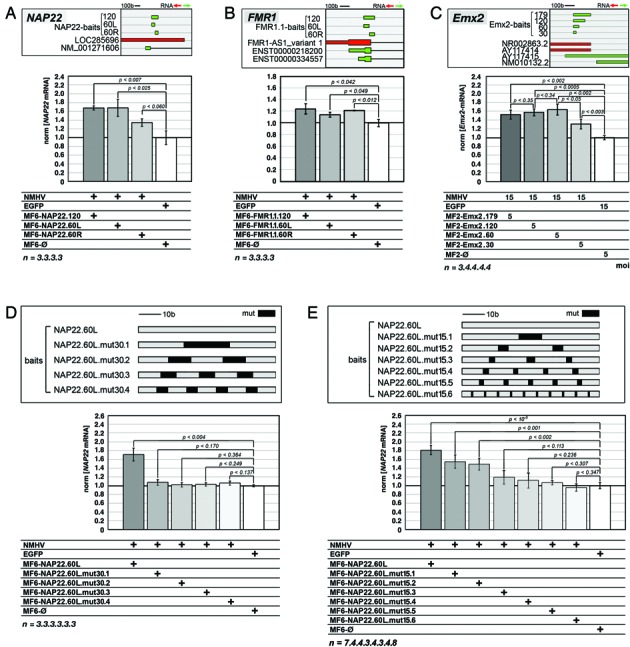
Consequences of RNA-bait shortening and mutagenesis. (A-C) Comparison of NMHV-dependent gene activation driven by select ‘primary’ baits, NAP22 (A), FMR1.1 (B) and Emx2-S (C), and ‘secondary’ baits obtained by heminested shortening of the former ones. (D, E) Full or partial suppression of NMHV-dependent NAP22 transactivation driven by the NAP22.60L bait, upon replacement of 30% (D) or 15% (E) of its original bases by mutant ones. Mutant bases were distributed in up to four (D) and up to 10 (E) equispaced mismatching modules, as shown in top panels (sequences of mutant baits are reported in Supplementary Table S7). Results were normalized against GAPDH (A, B, D, E) and Gapdh (C) and further normalized against EGFP/MF6-ø(A, B, D, E) and EGFP/MF2-ø(C) control samples. Time frame of the experiments as well as representation of moi's and statistical parameters was as in Figures 1 (A, B, D, E) and 3 (C).